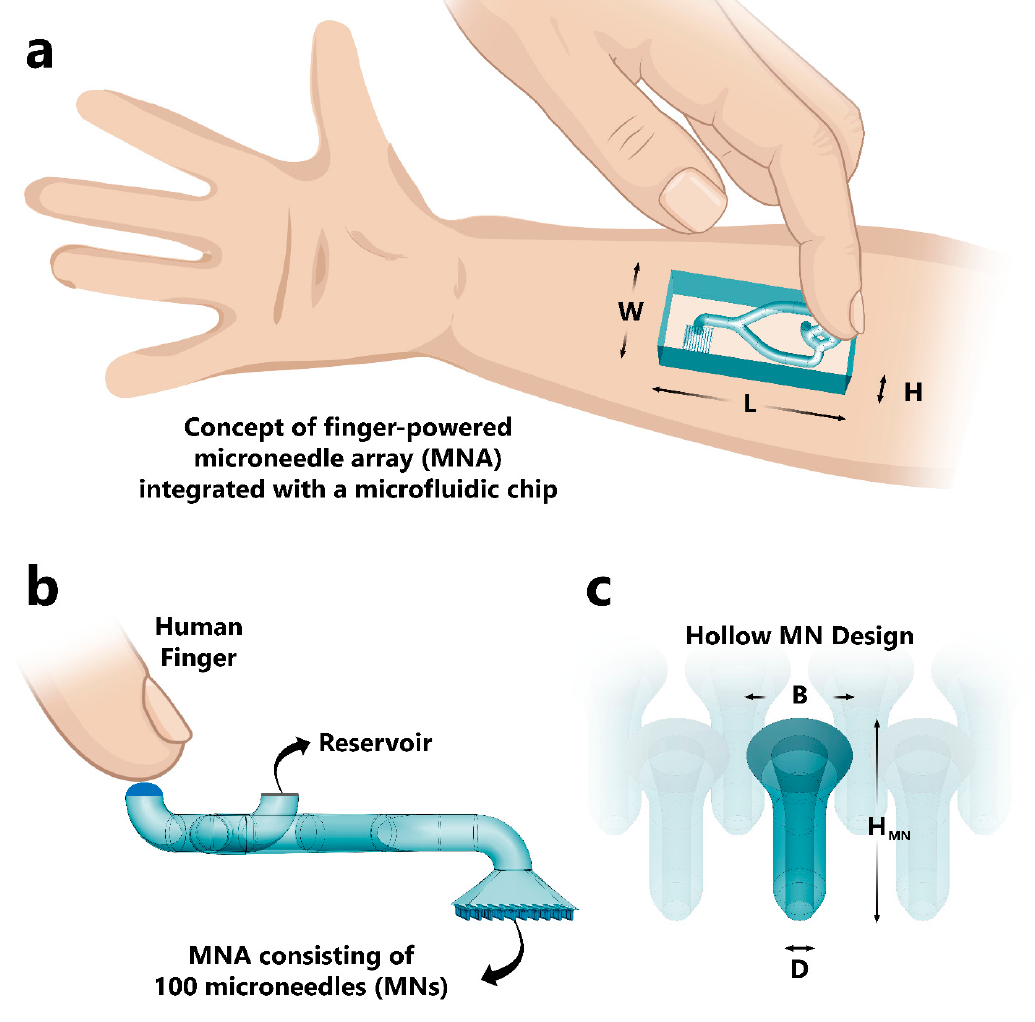
Figure 1. Concept of finger-powered microneedle array (MNA) integrated with a microfluidic chip for the aim of extracting body fluid samples. ( a ) The device is designed to be powered by pressing with a finger, hence enabling a simple approach that the user can sample easily without need for healthcare workers, as shown schematically. The dimensions of the designed device are as follows: length, L = 40 mm; width, W = 20 mm; and height, H = 9.3 mm. ( b ) The design of the channels of the chip, in which the array of 100 microneedles (MNs) is connected to a duct that guides the extracted fluid to the reservoir via the channels by means of pressing with a finger. ( c ) The geometry of each MN, consisting of a hollow design with the following dimensions: height, H MN = 700 µm; diameter of the needle tip, D = 80 µm; and the diameter of the needle base, B = 300 µm.